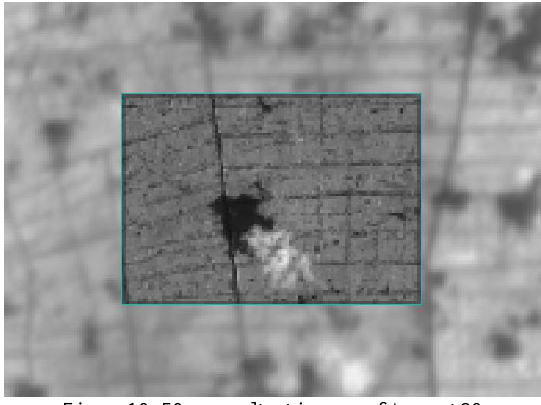
Figure 10. 50 m resultant images of August